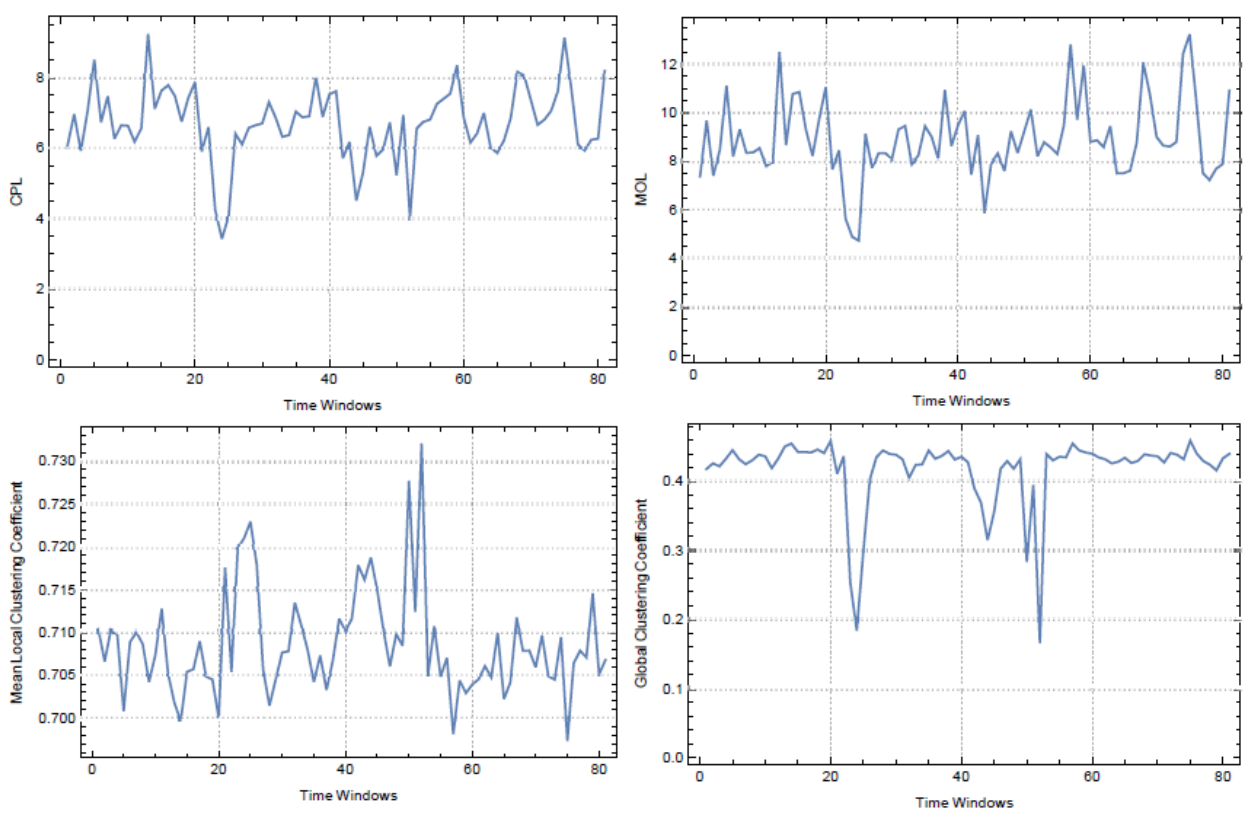
Figure 5. CPL and MOL measures for Maximal Spanning Trees, weighted local and global clustering coefficients of 𝐺 (cid:3021)(cid:3037) for BIST.